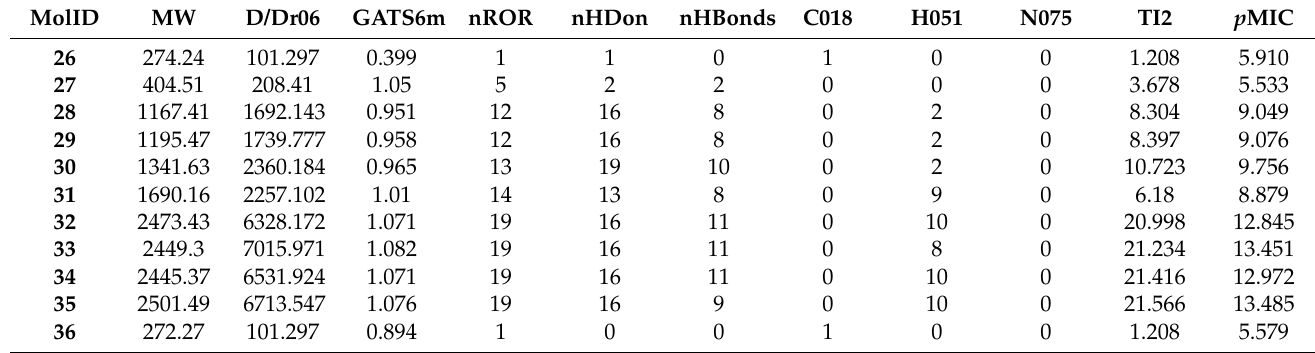
Table 1. Molecular descriptor values for natural products 26 to 53 with their predicted p MIC value. These molecules show the highest values from the BIOFACQUIM